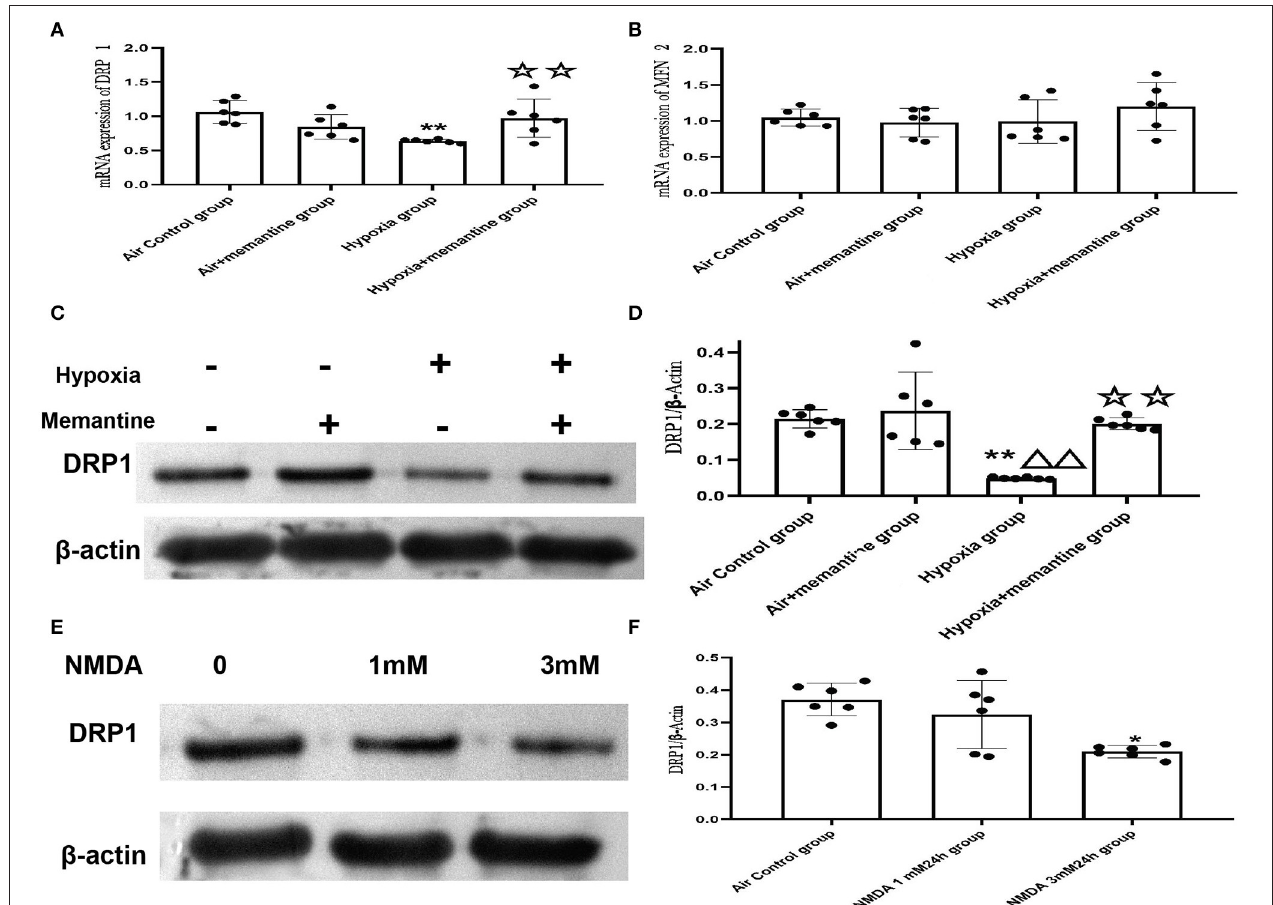
FIGURE 10 | Intrauterine hypoxia in vivo or NMDA exposure in vitro decreased the expression of DRP1. (A,B) mRNA expression of DRP1 (A) and MFN2 (B) ; (C,D) : The representative western blot images of DRP1 in IUH animal model (C) and semi-quantified level of DRP1 (D) ; (E,F) : The representative western blot images of DRP1 after NMDA exposure (E) and semi-quantified level of DRP1 (F) ; Compared with the air control group: * P < 0.05, ** P < 0.01; compared with the air+Memantine group: △ P < 0.05, △△ P < 0.01; compared with the hypoxia group: P P < 0.05, PP P < 0.01. All data are presented as mean ± S.E.M. ( N = 6 in vivo , N = 3 in vitro